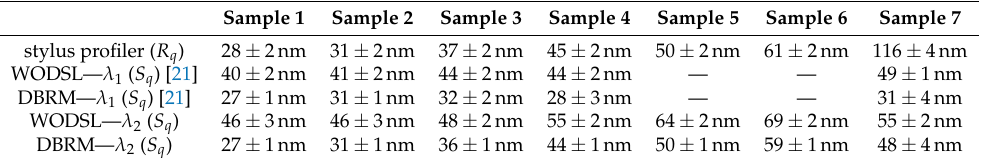
Table 1. Experimental results for seven samples measured by the stylus profiler, Chandley’s method without considering the depolarization of the scattered light (WODSL), and the DBRM method with λ 1 = 488.0nm and with λ 2 = 632.8nm considering the depolarization of the samples. Additionally, the uncertainties of the measurements are